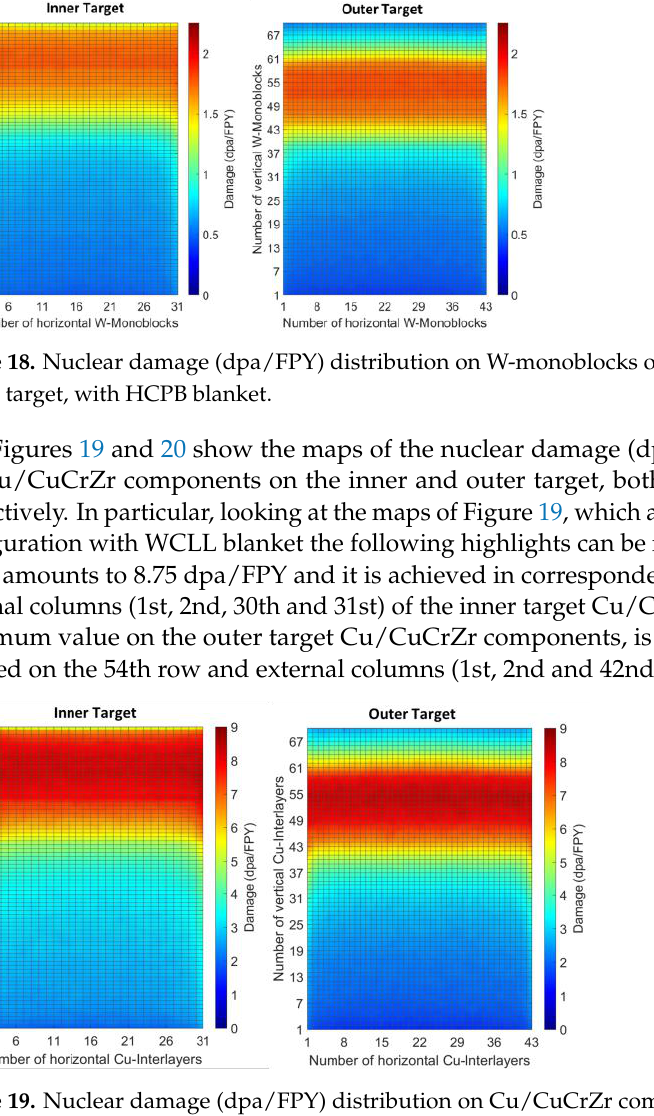
Figure 17. Nuclear damage (dpa/FPY) distribution on W-monoblocks of the inner ( left ) and outer ( right ) target, with WCLL blanket.